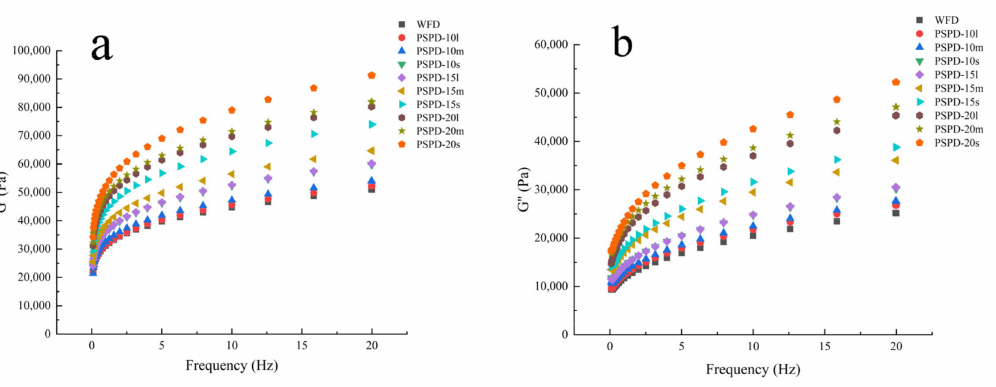
Figure 1. Mechanical spectra G’ ( a ) and G” ( b ) of WFD and PSPD samples with different levels (10%, 15%, and 20%) and different particle sizes (l, m, s) of PSPF.